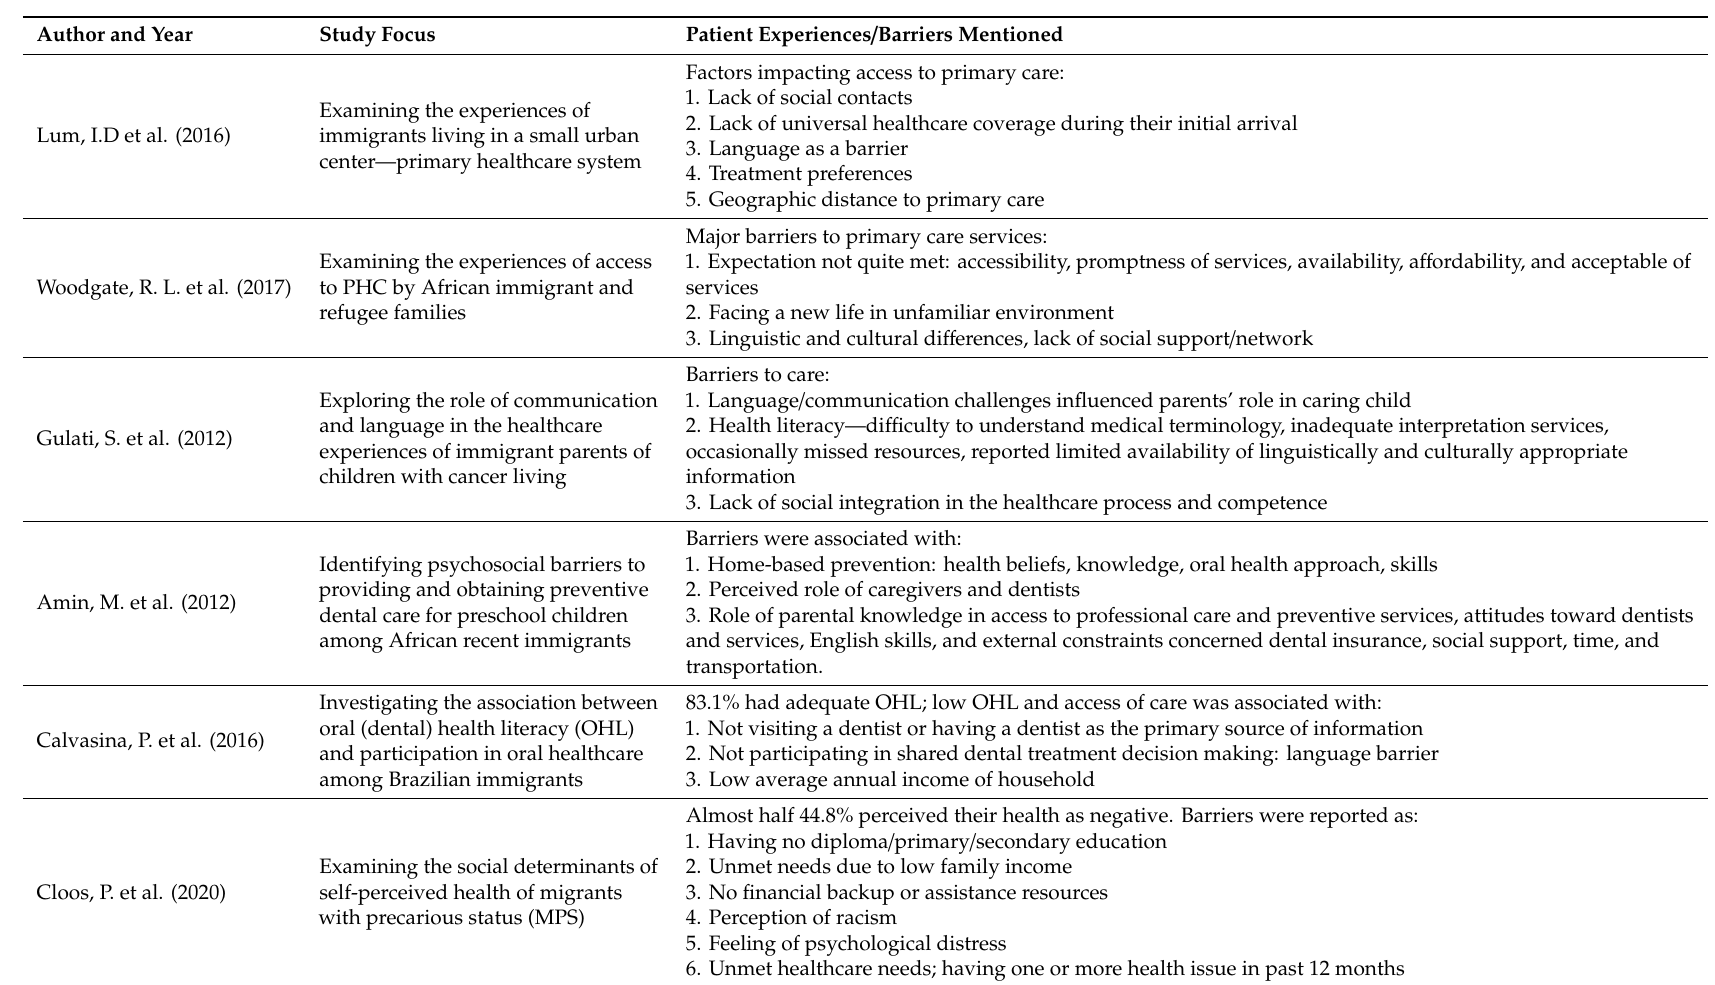
Table 2. Findings of the studies included in the